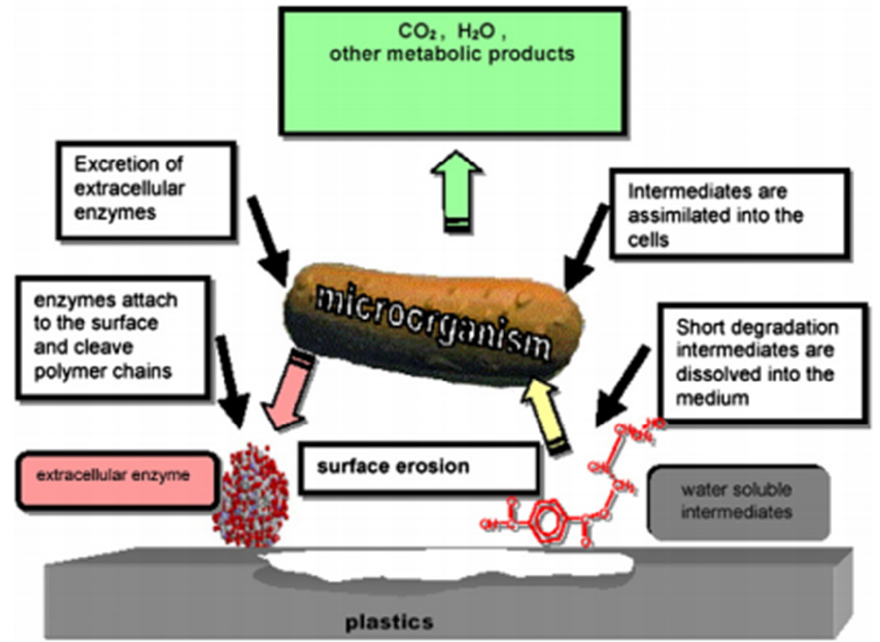
Figure 2. Enzymatic biodegradation process [44].